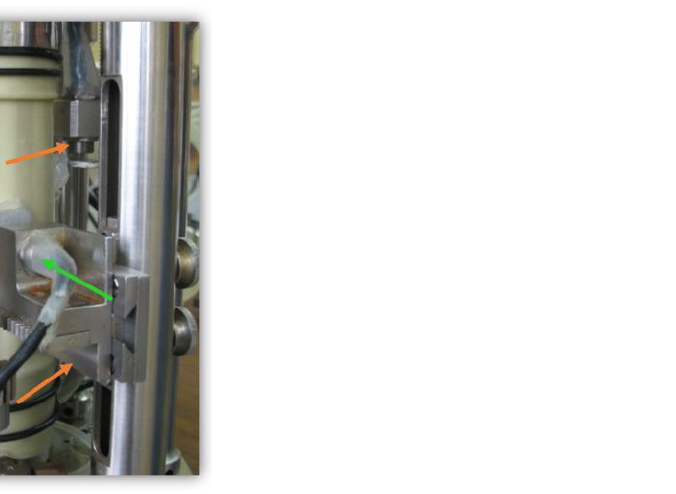
Figure 4. PT mounted on a sample (source: photo of Jastrzębska M., after [41]; available via 2021 Civil and Environmental Engineering’s permission).